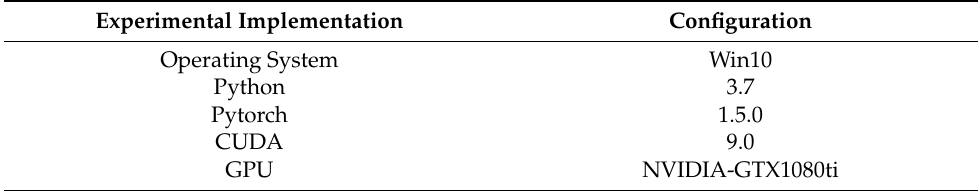
Table 1. Configuration details of the experimental